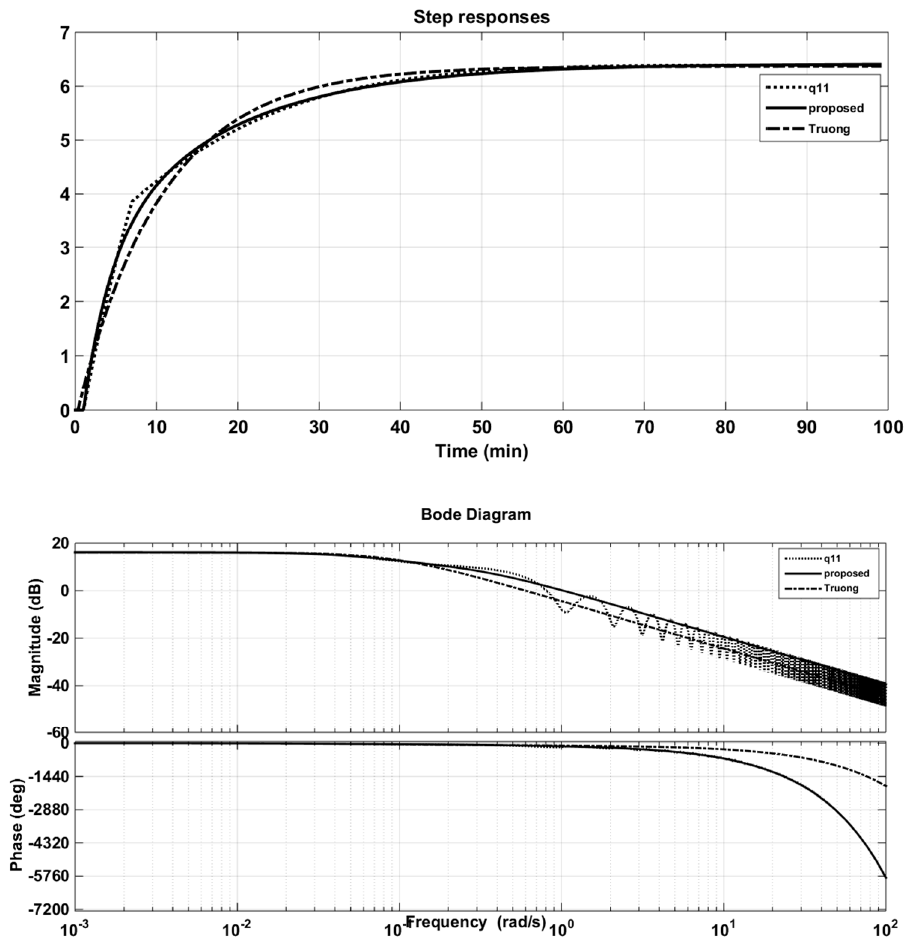
Figure 8. Step and Bode responses of original q 11 and its approximations (Wood and Berry (WB) column).